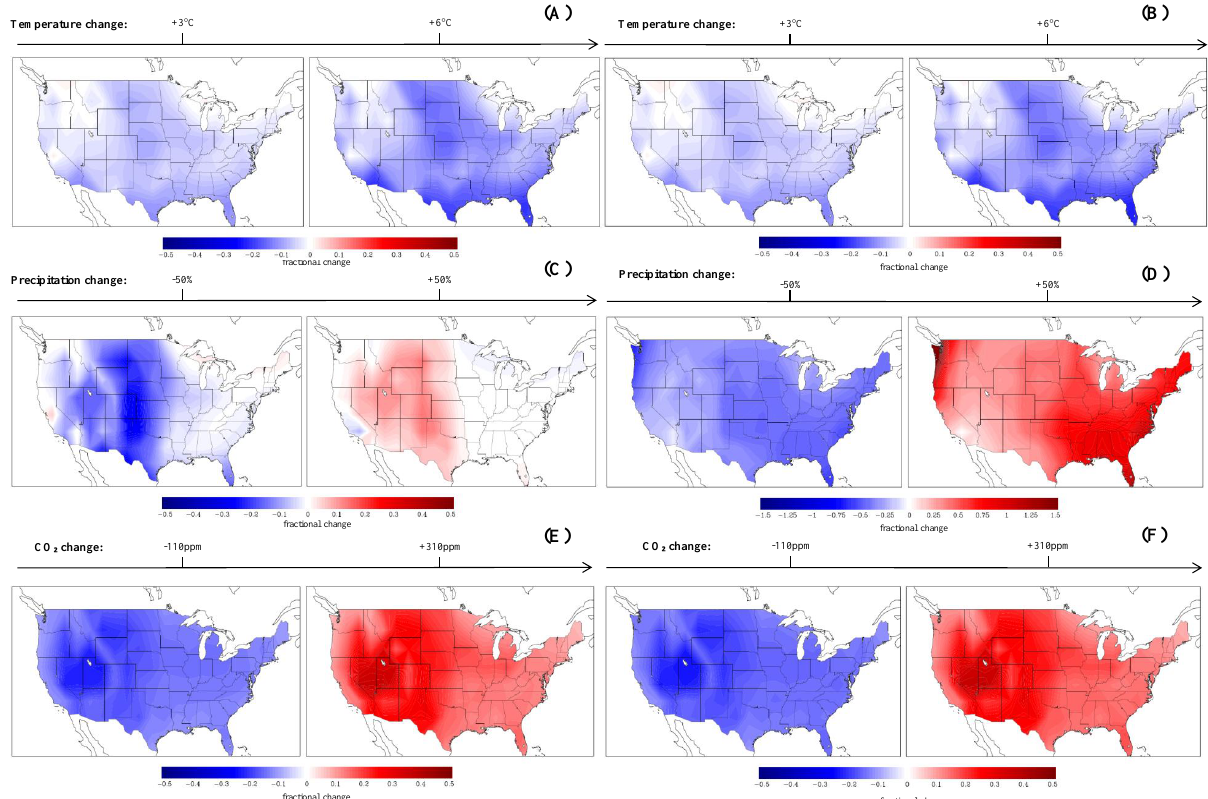
Fig. 4. Main effects of temperature, precipitation and CO 2 on top soil carbon (A, C, E) and top soil mercury densities (B, D, F) . The values are expressed as the fractional change of present-day